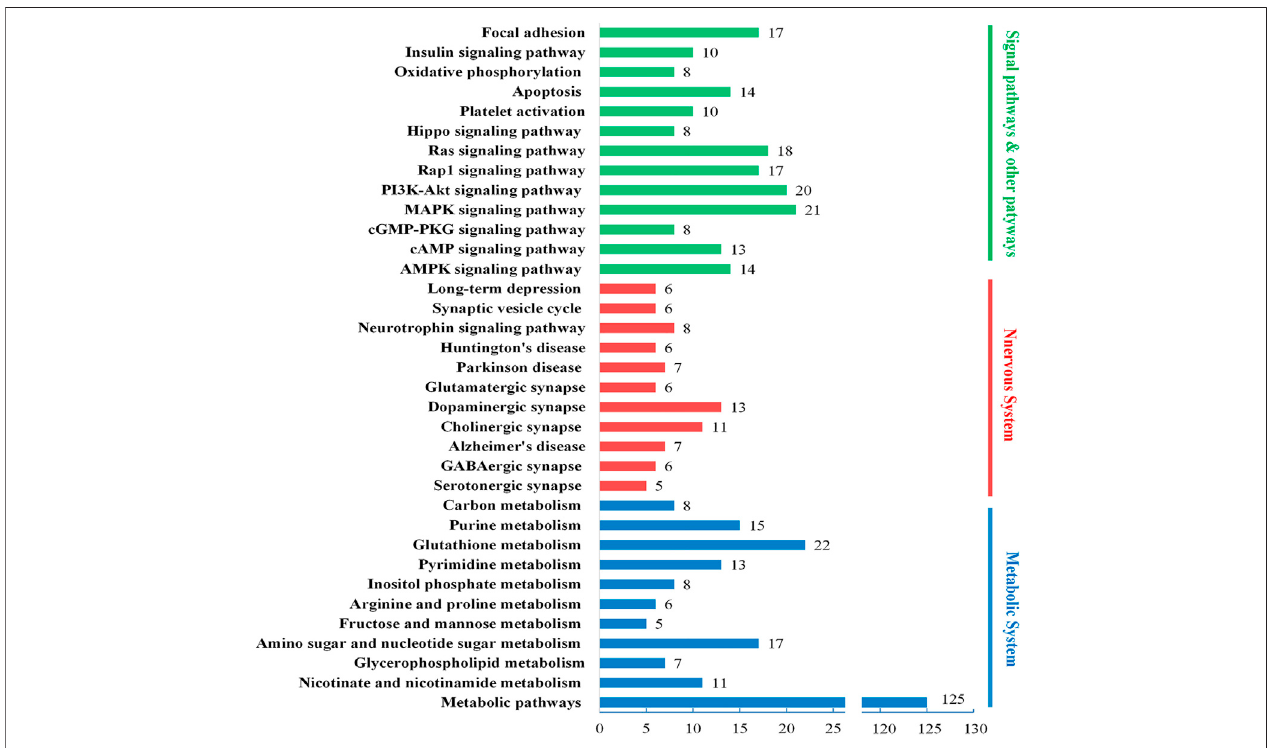
FIGURE 6 | Biological process enrichment of the DAPs. Different colors represent different biological processes: blue for energy metabolism, red for the nervous system, and green for several signaling pathways. The number of every column implied the number of proteins classi fi ed in each pathway.